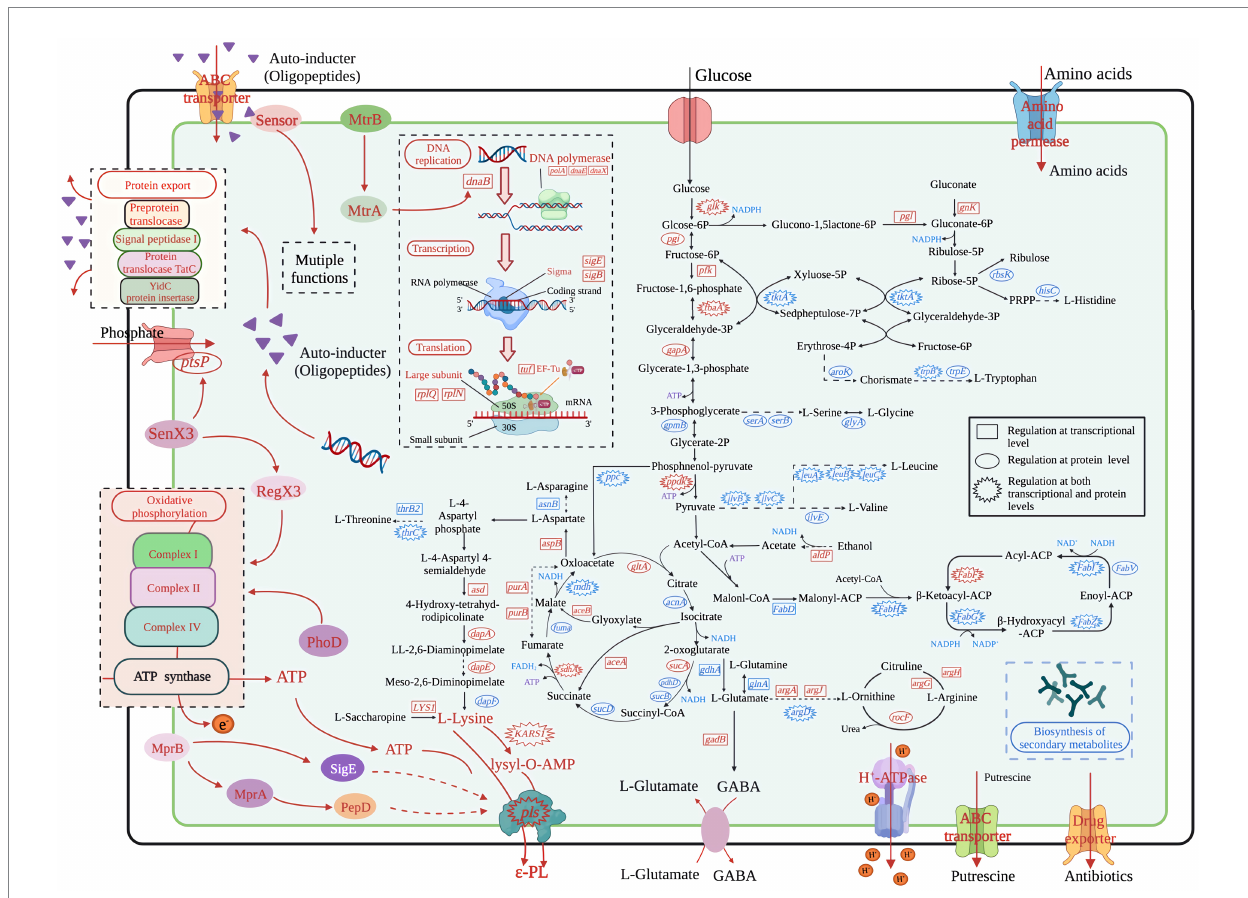
FIGURE 3 Overview of the transcriptional and translational regulation in the high ε -PL producer S. albulus WG-608. Red represents transcriptional upregulation/ increased protein accumulation, whereas blue represents downregulation/decreased protein